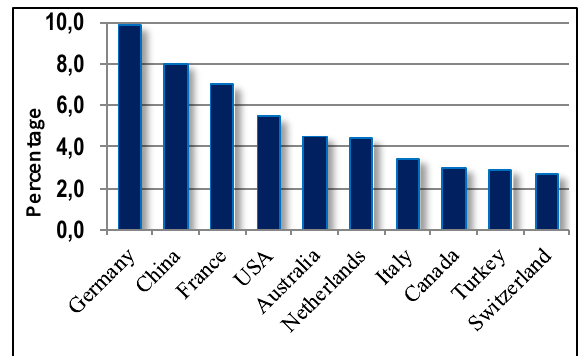
Figure 17. Top ten countries, making major contribution in